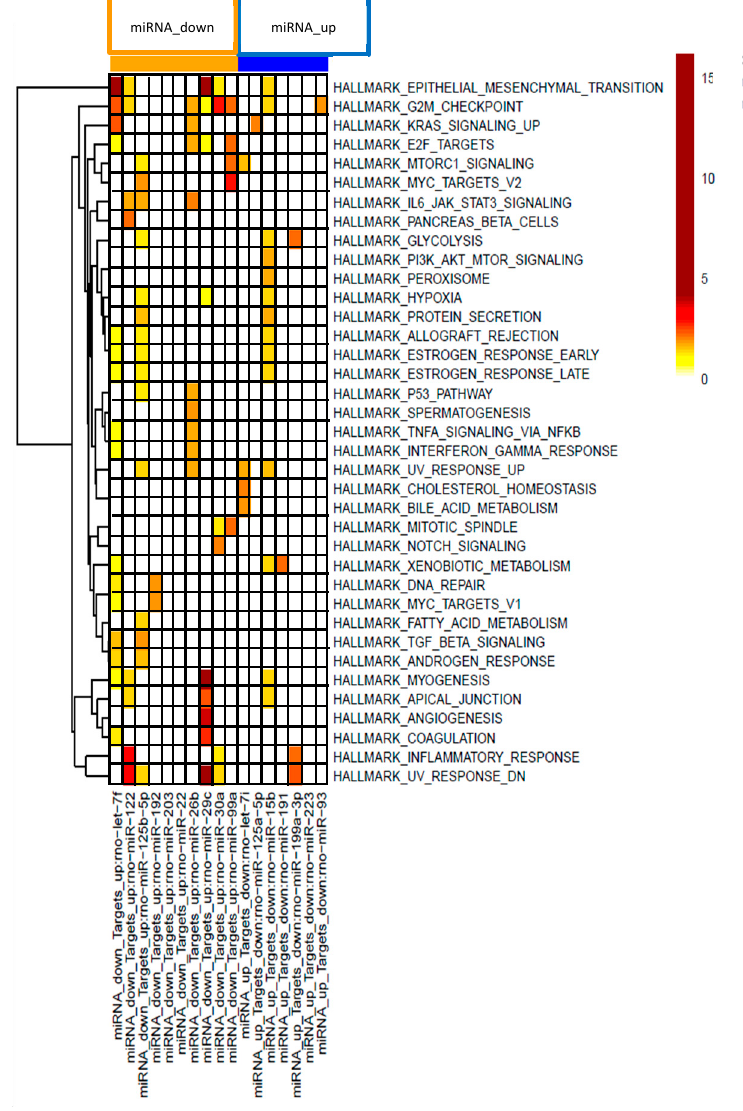
Figure 4. Gene set enrichment analysis of miRNA ‐ mRNA pairs according to 37 hallmark pathways. Effects on distinct pathways are represented by colors indicating enrichment scores.